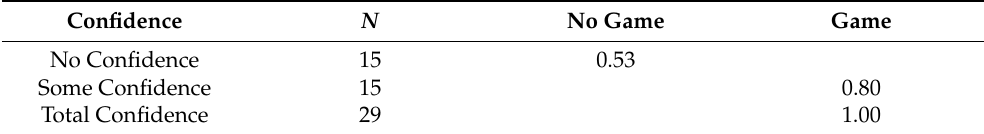
Table 3. Turkey’s Post Hoc Test of Confidence. Confidence N No